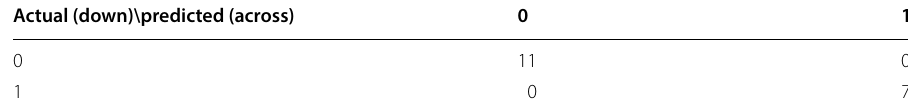
Table 9 Confusion matrix using best-rated features from FIS Actual (down)\predicted